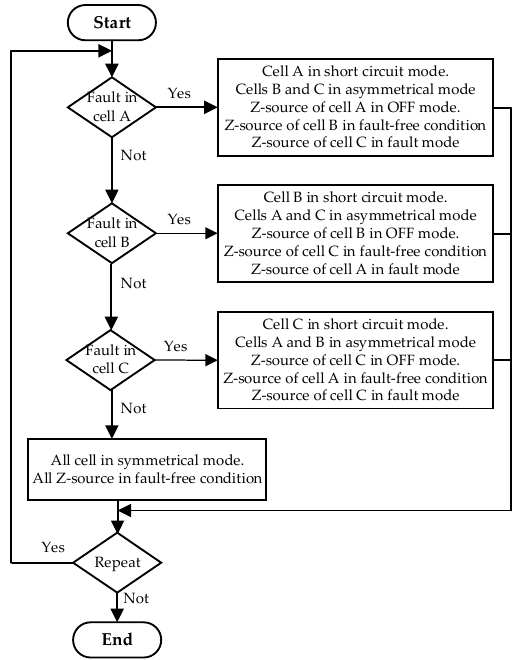
Figure 9. Flowchart of the methodology used.